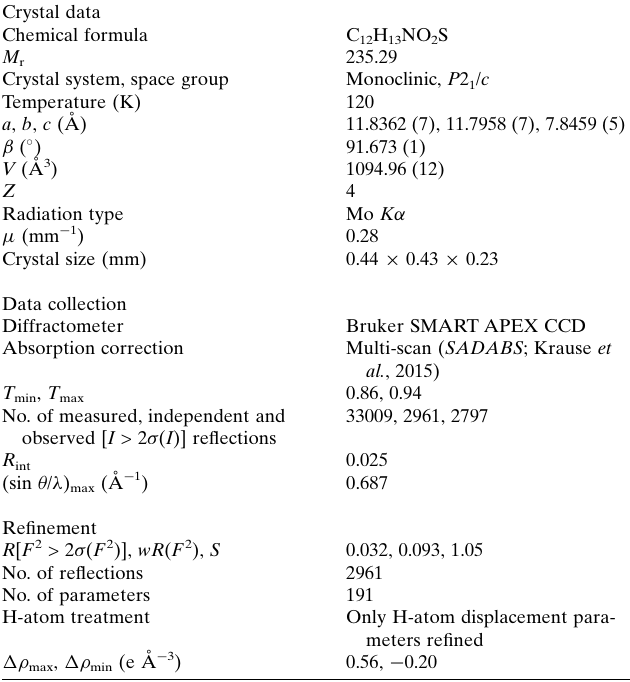
Crystal data Chemical